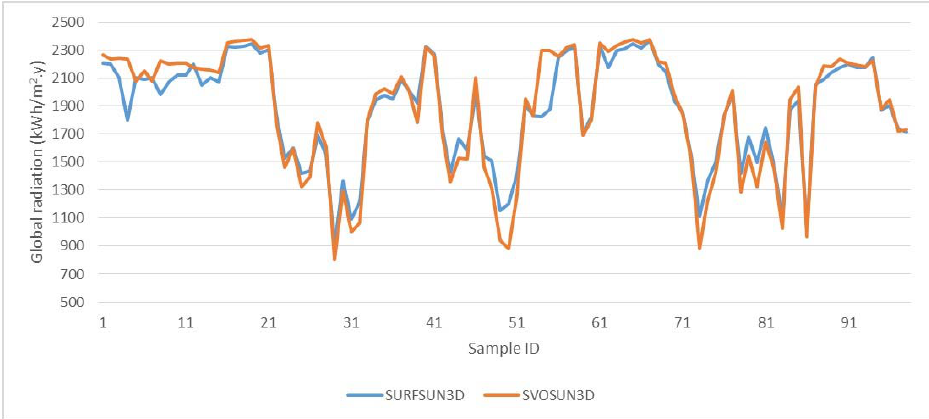
Figure 17. Comparison of annual global radiation with SURFSUN3D at the sample locations.